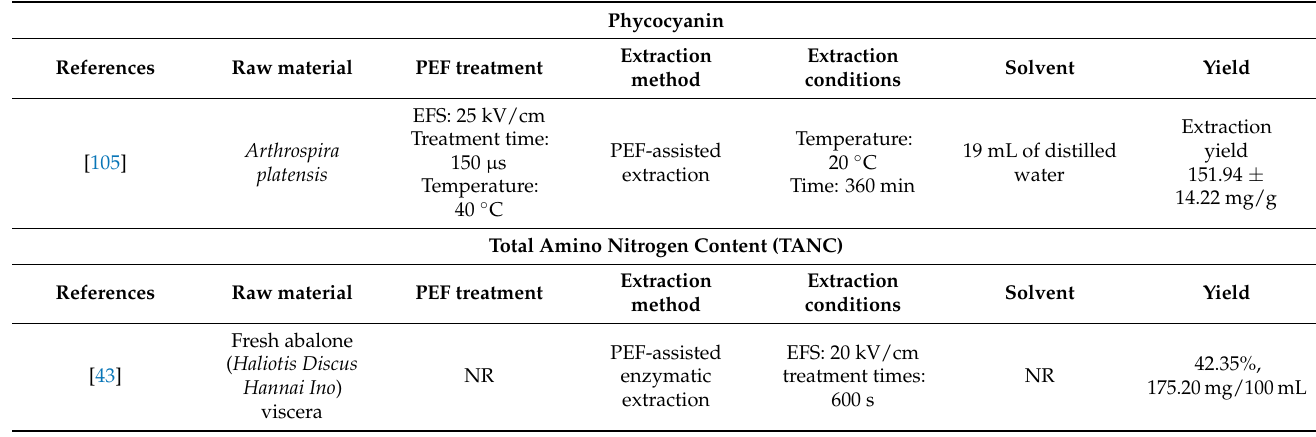
Table 4. The extraction of other